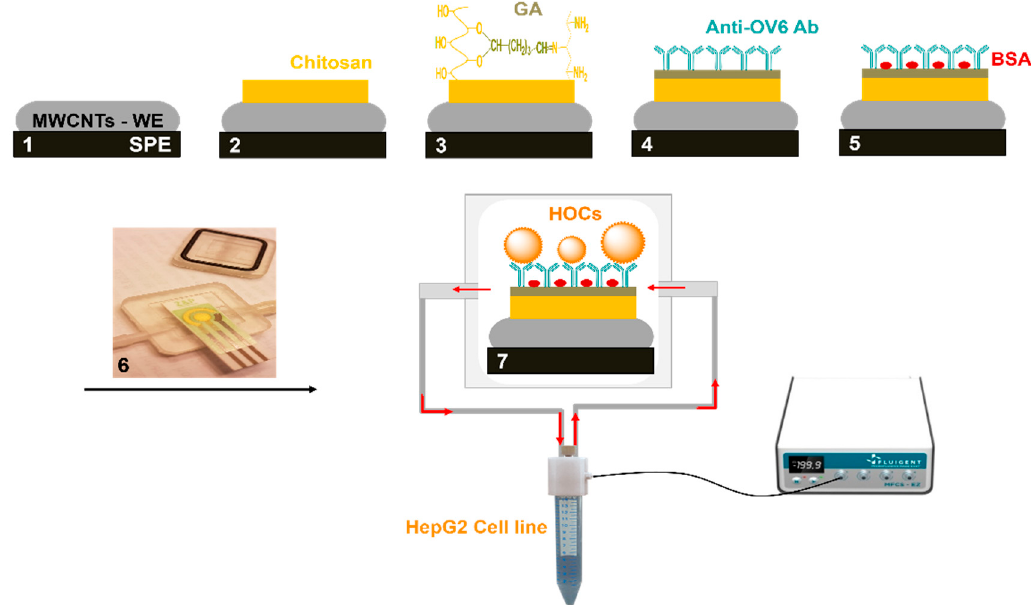
Figure 1. Schematic representation of the fabrication of the electrochemical biosensor for detection of oval cells in the HepG2 cancer cell line in a circulatory platform (not shown to scale). ( 1 ) Working electrode (WE) of multiwall carbon nanotube (MWCNTs); ( 2 ) modification of electrode surface with chitosan; ( 3 ) chitosan film crosslinked with glutaraldehyde (GA); ( 4 ) immobilization of anti-OV6 antibody onto the activated surface; ( 5 ) blocking the surface with bovine serum albumin (BSA); ( 6 ) embedding the developed sensor into the 3D-printed flow cell; and ( 7 ) connecting to a flow control system to allow for continuous exposure of the cancer cells over the sensor architecture. SPE: screen printed electrode; Ab: antibody.